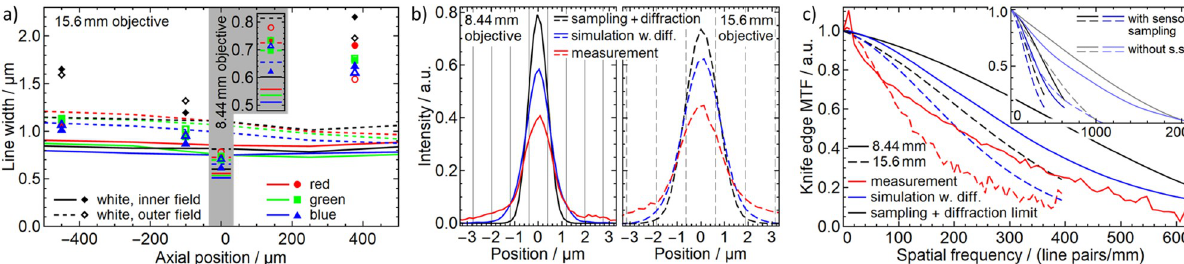
Fig 5. a) measured and simulated RMS line width. The data in the gray region relates to the 8.44mm objective. b) mean LSF, oversampled by a factor of 5. The grid lines indicate the pixel size. c) MTF in the central FoV and a central axial position. The inset compares the MTF from actual simulated and sampled edge images to the simulated ideal